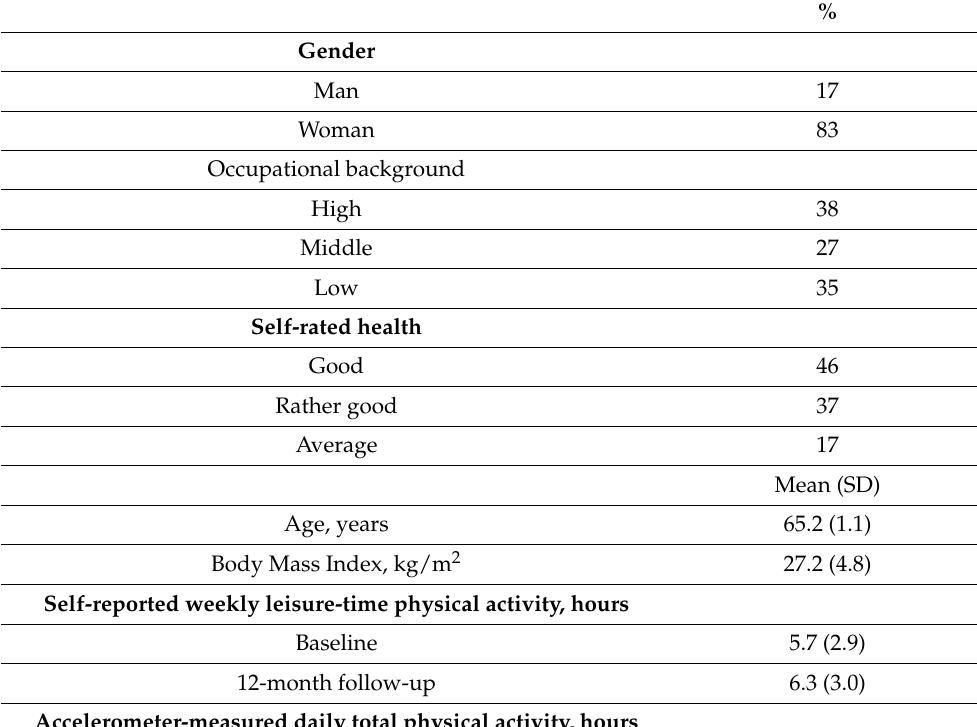
Table 1. Participant characteristics ( n =